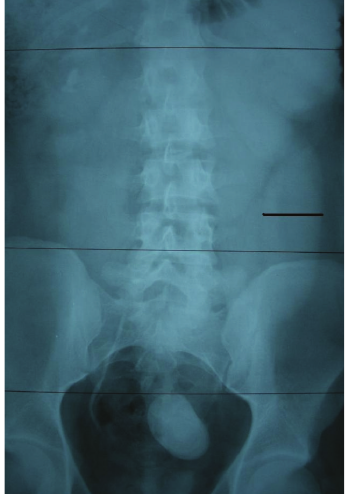
Figure 2: Preoperative intravenous pyelography.